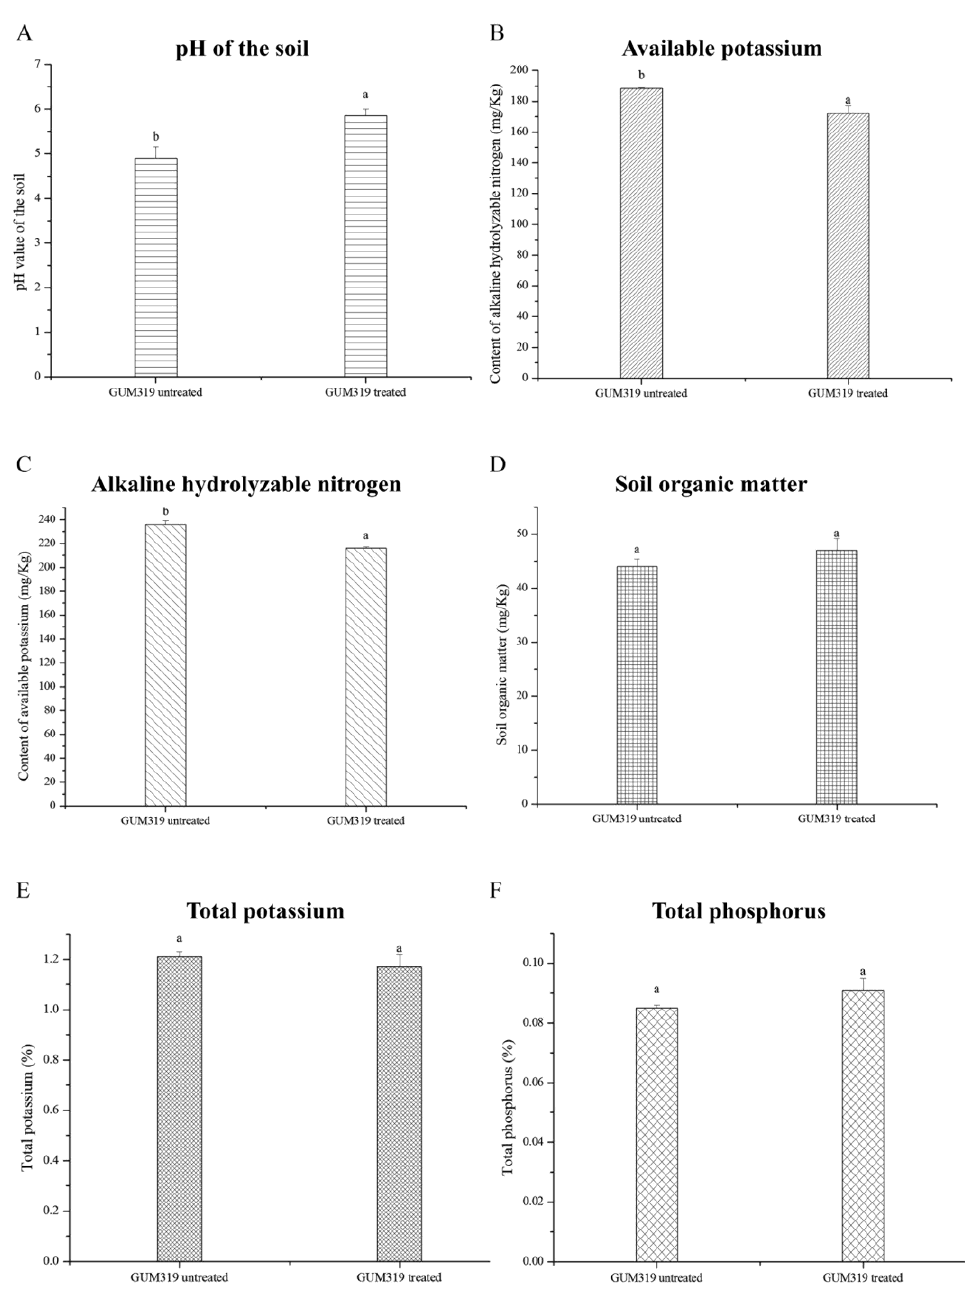
Figure 3. Properties of the GUMT319-treated and untreated soil. The error bars represent standard deviation (SD). ( A ) The pH value of the soil: GUMT319 untreated 4.90 ± 0.26 b, and GUMT319 treated 5.85 ± 0.15 a. ( B ) The content of available potassium: GUMT319 untreated 188.33 ± 0.47 b, and GUMT319 treated 172.33 ± 4.71 b (mg/Kg) ( C ) The content of alkaline hydrolyzable nitrogen: GUMT319 untreated 236.16 ± 3.00 b, and GUMT319 treated 215.94 ± 1.32 a (mg/Kg). ( D ) The content of soil organic matter: GUMT319 untreated 47 ± 2.22 a, and GUMT319 treated 47 ± 1.43 a (mg/Kg). ( E ) The ratio of total potassium: GUMT319 untreated 1.21 ± 0.02 a, and GUMT319 treated 1.17 ± 0.05 a (%). ( F ) The ratio of total phosphorus: GUMT319 untreated 0.085 ± 0.001 a, and GUMT319 treated 0.091 ± 0.004 a (%).